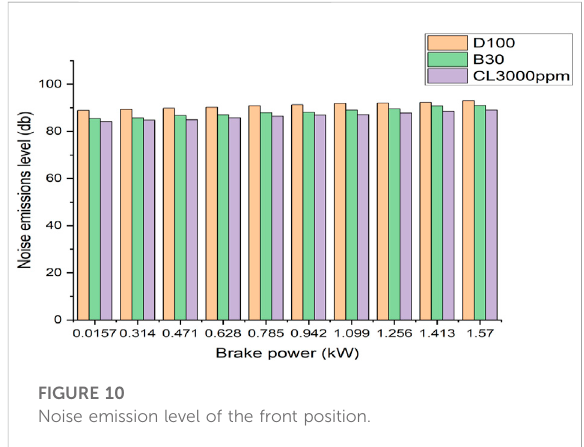
FIGURE 10 Noise emission level of the front